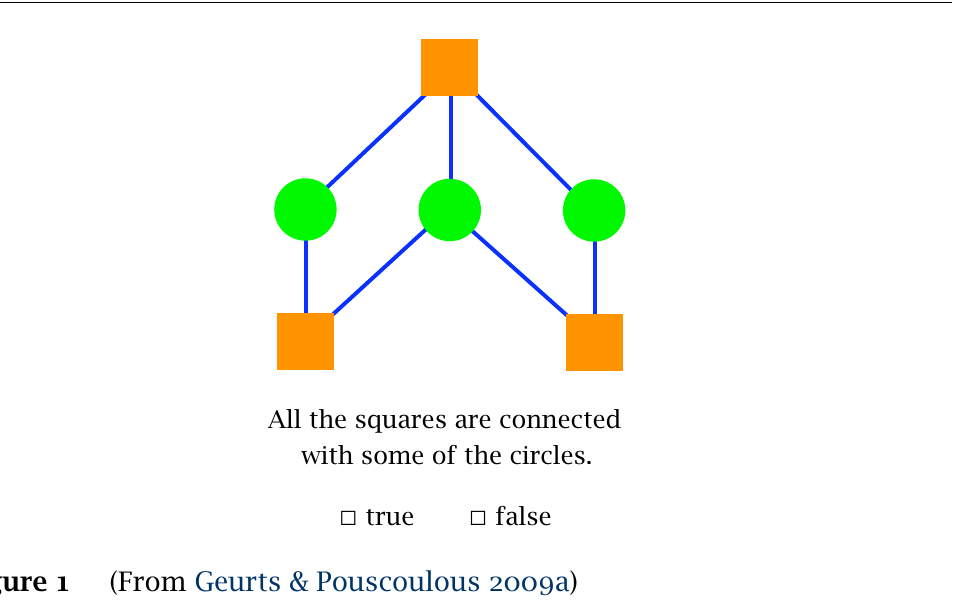
Figure 1 (From Geurts & Pouscoulous 2009